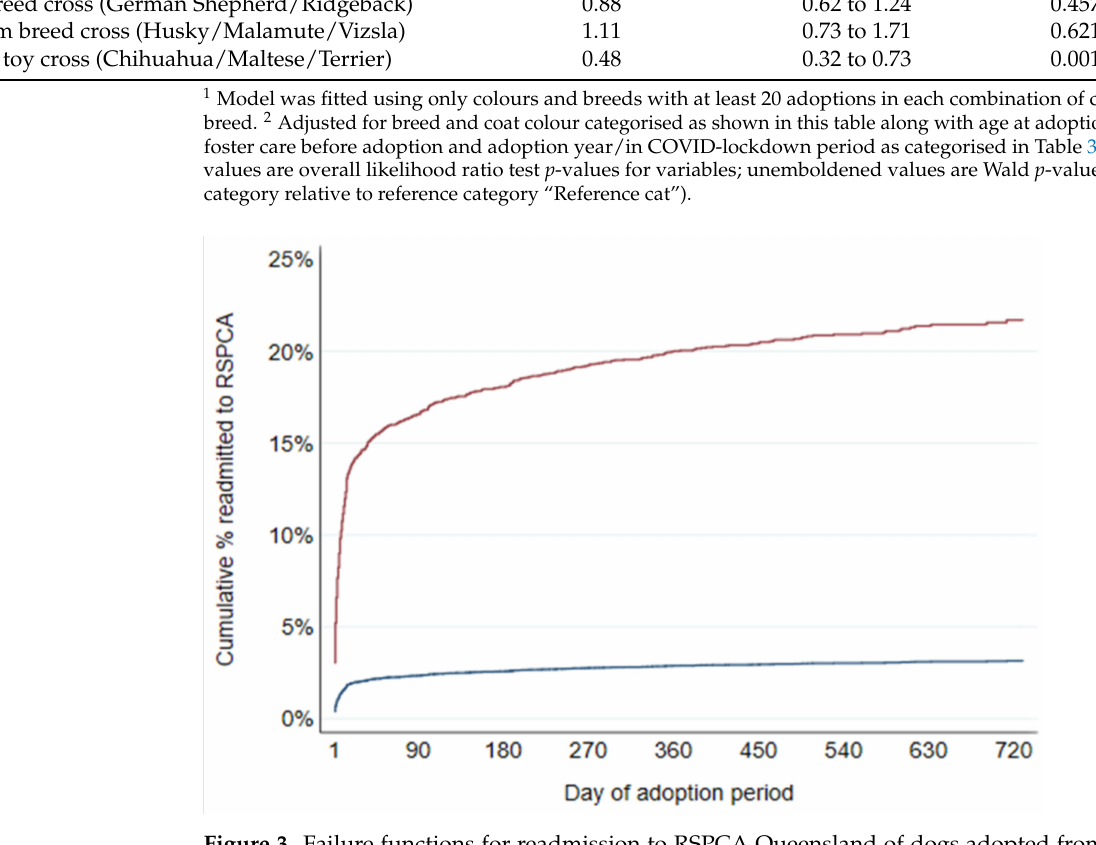
Figure 3. Failure functions for readmission to RSPCA Queensland of dogs adopted from RSPCA Queensland in 2019 and 2020, by day of adoption period for a high-risk example (upper line; maroon) and a low-risk example (lower line; blue) example covariate pattern. Population